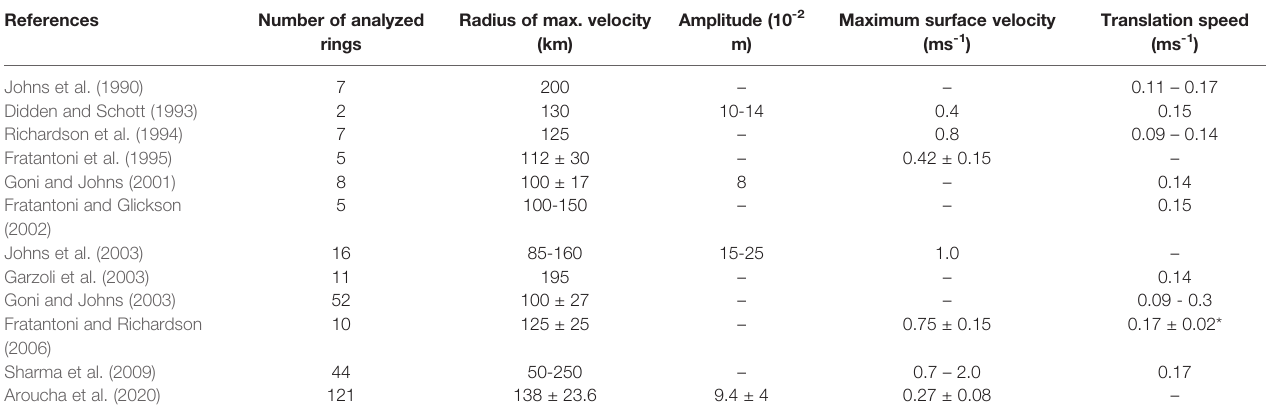
TABLE 3 | NBC ring properties from previous observational studies.